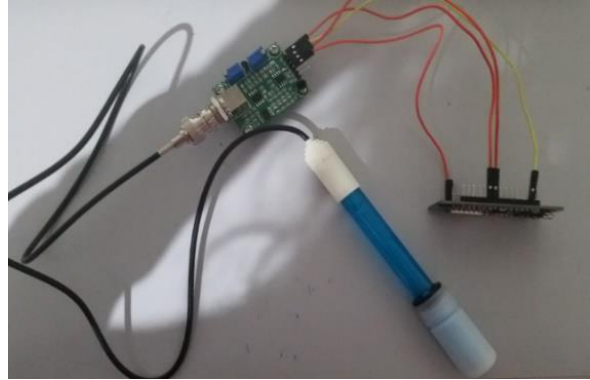
Figure 13. YL-69 wiring diagram with ESP8266